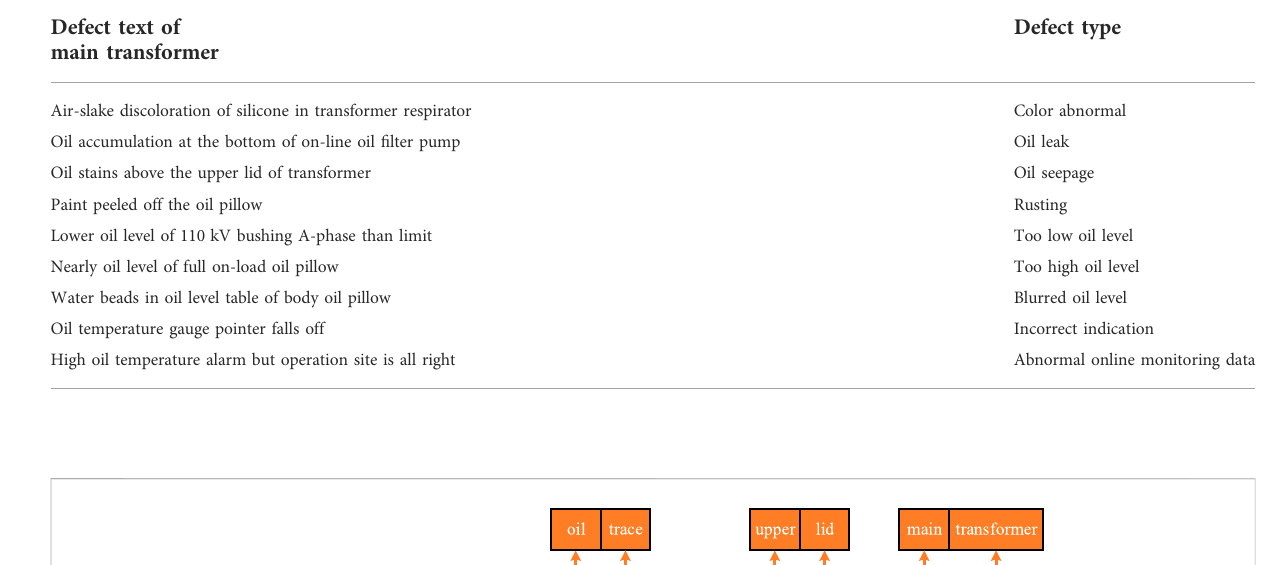
TABLE 1 Examples of power operation inspection defect text and defect type.